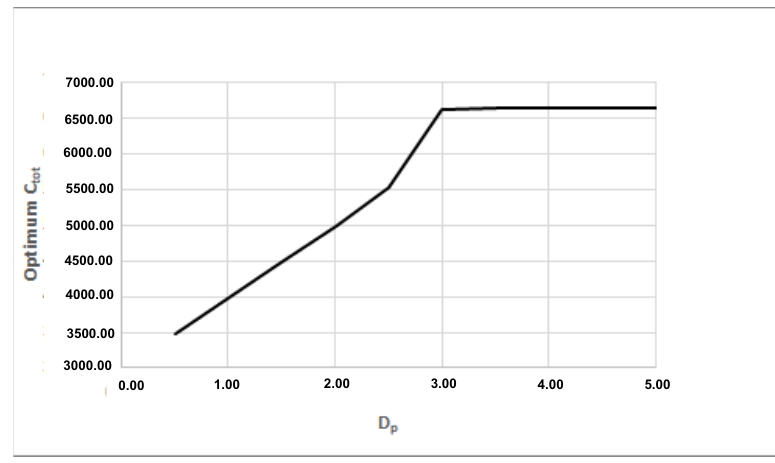
, RUL lim sup ] per c dt . inf